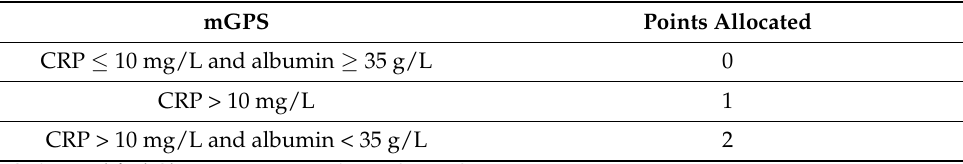
Table 1. The modified Glasgow Prognostic Scores. mGPS Points